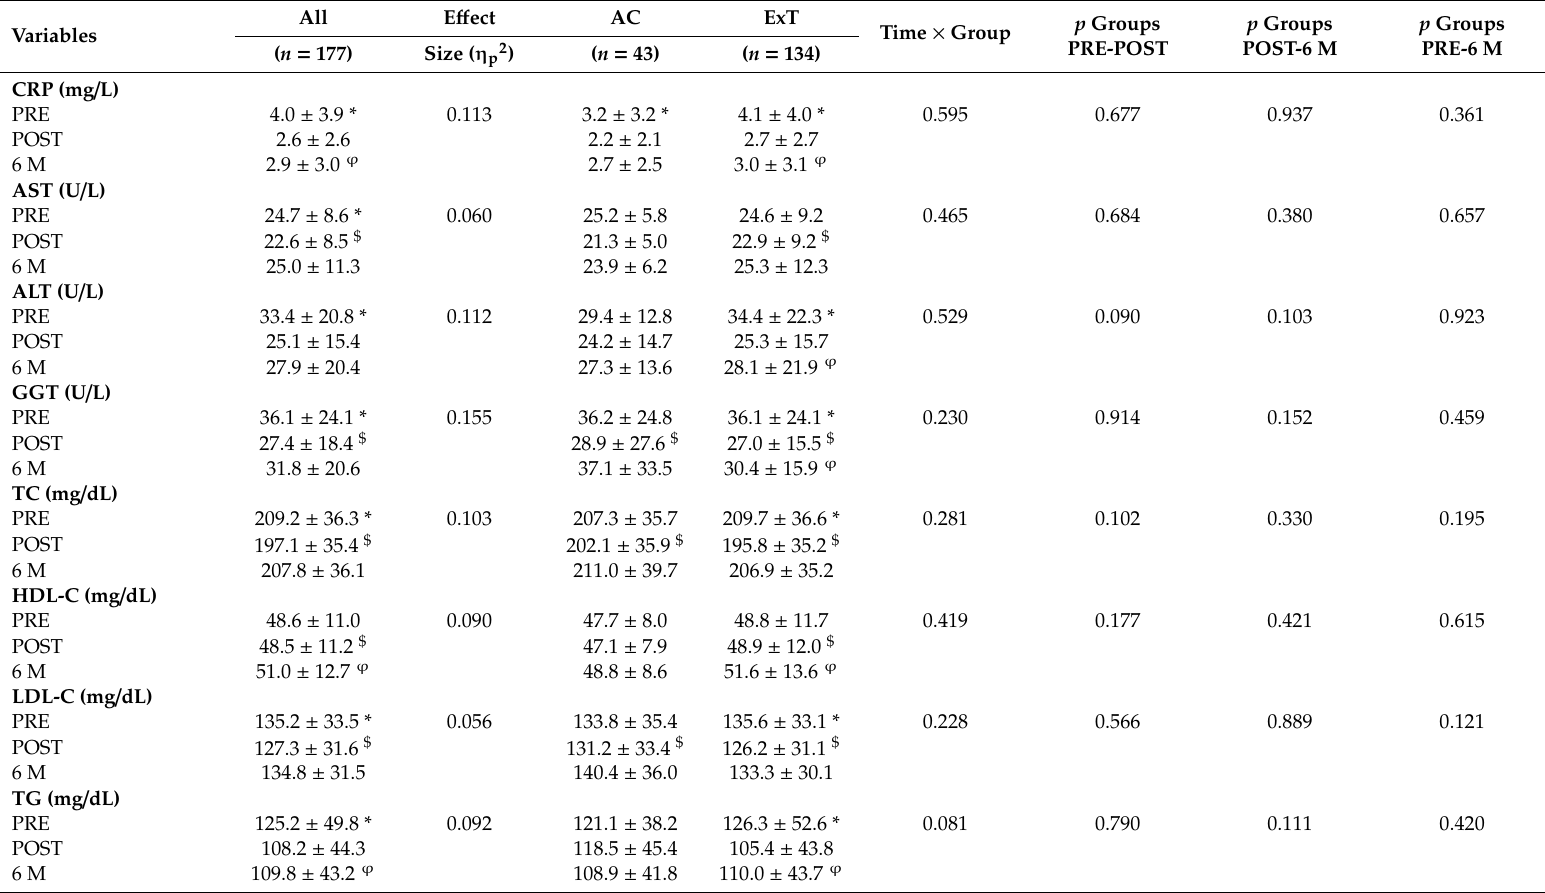
Table 2. Changes in metabolic panel at pre-intervention (PRE), immediately post-intervention (POST), and 6 months post supervised exercise cessation (6 M).